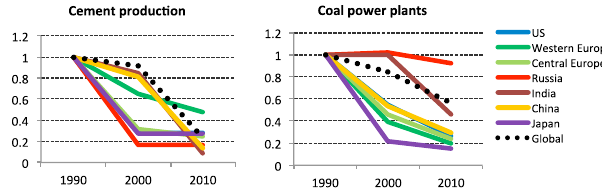
Figure 3. Change in implied PM 2 . 5 emission factors for cement production and coal power plants in selected countries and world regions; changes relative to 1990 in ECLIPSE V5a